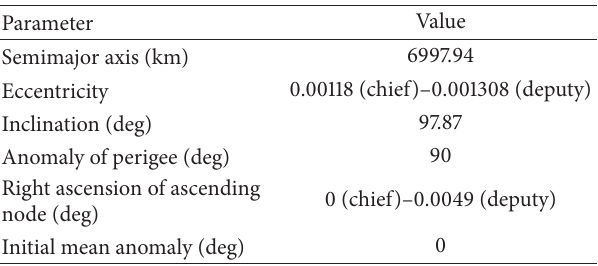
Table 1: Parameters of the selected helix